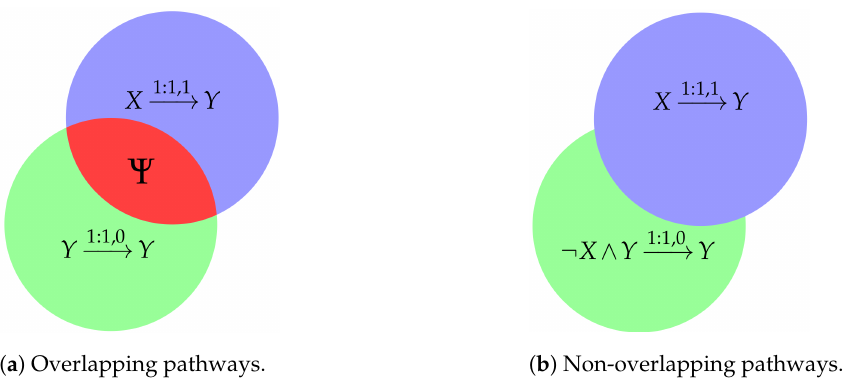
Figure 2. Graphic representation of the conflict avoidance. Each circle symbolise the support of the antecedent of a pathway. The red region Ψ indicates the overlap between the two supports, that in this case is Ψ = X ∧ Y